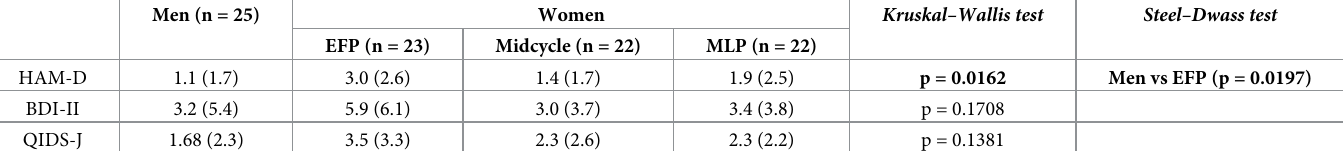
Table 4. Sex differences in scores on depression rating scales.